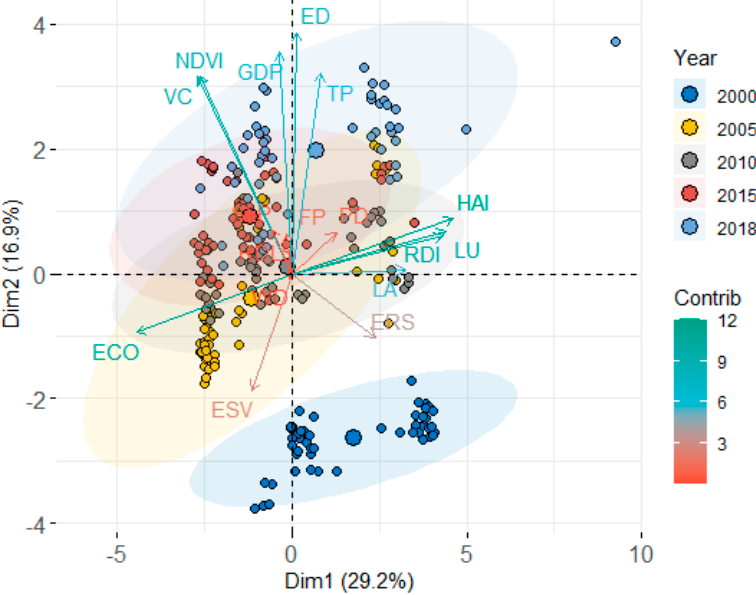
Figure 5. Principal component analysis of land ecological security in Yan’an from 2000 to 2018. Contrib. represents contribution rate of each factor to LES; LES represents land ecological security; TP represents land surface temperature; VC represents vegetation coverage; NDVI represents normalized differential vegetation index; ERS represents soil erosion; ESV represents the value of the ecosystem service; HAI represents human disturbance index; SLP represents slope; RDLS represents topographic relief; ECO represents the elasticity of ecological environment; BZ represents buffer zone; RDI represents regional development index; ED represents economic density; GDP represents gross domestic product; LU represents the degree of land use; LA represents arable land per capita; WD represents water coverage; PD represents the density of the population; FP, grain yield. Table 5. Stepwise regression analysis of factors affecting LES. LES represents land ecological security. ANOVA represents the analysis of variance.